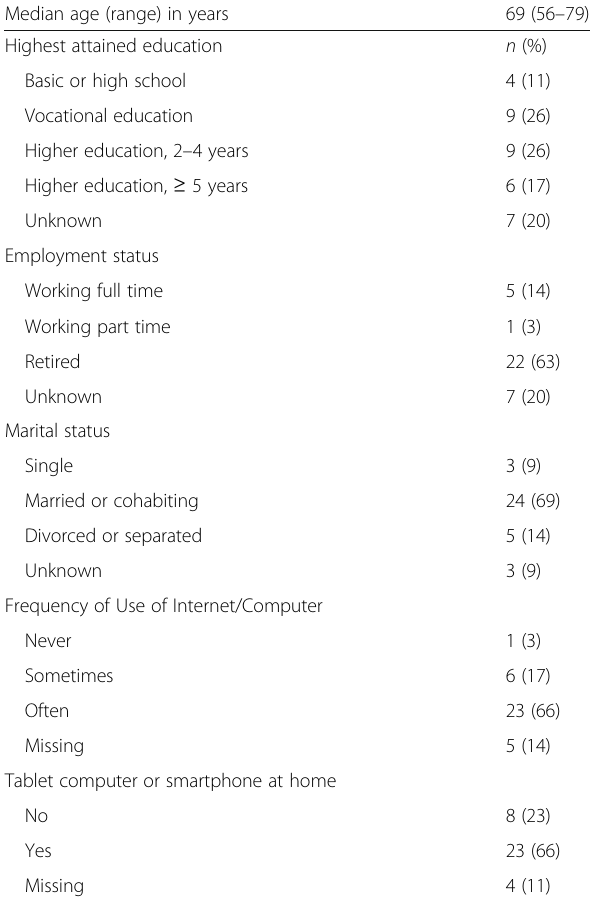
Table 3 Characteristics of patients who completed the structured evaluation questionnaire ( n =